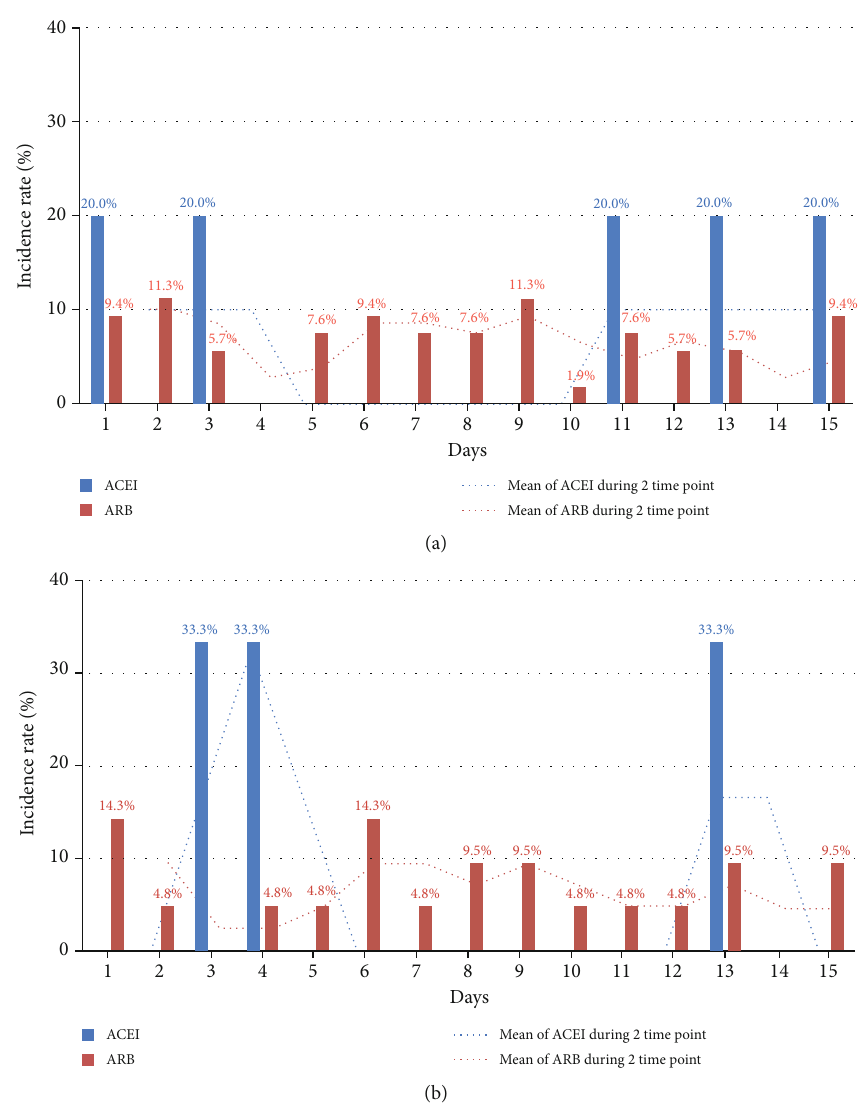
Figure 2: Occurrence of hyperkalemia during hospitalization after ACEI or ARB use at (a) > 5.5 mEq/L and (b) 6.0mEq/L cuto ff